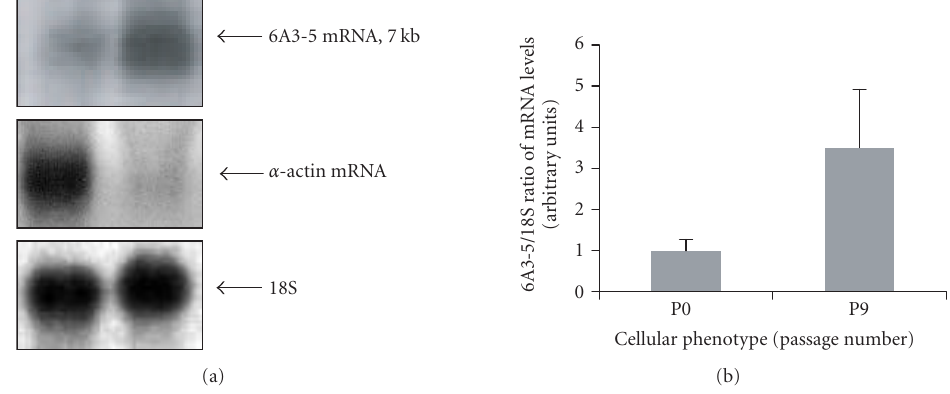
Figure 4: 6A3-5 and α -actin SMC expression in di ff erent vascular SMC . (a) Levels of 6A3-5 gene transcription were compared, by northern blot, between the contractile (passage 0, P0) and the secretory/synthetic phenotype (9th passage, P9). Phenotypes were characterized by the α -actin SMC marker. The 18S served as a control for loading and quantification. (b) Quantification of 6A3-5 signals, done on 3 indepen- dent northern blots, reported to the 18 S levels. Results show 6A3-5 mRNA levels to be increased by 3 folds in synthetic cells compared to contractile